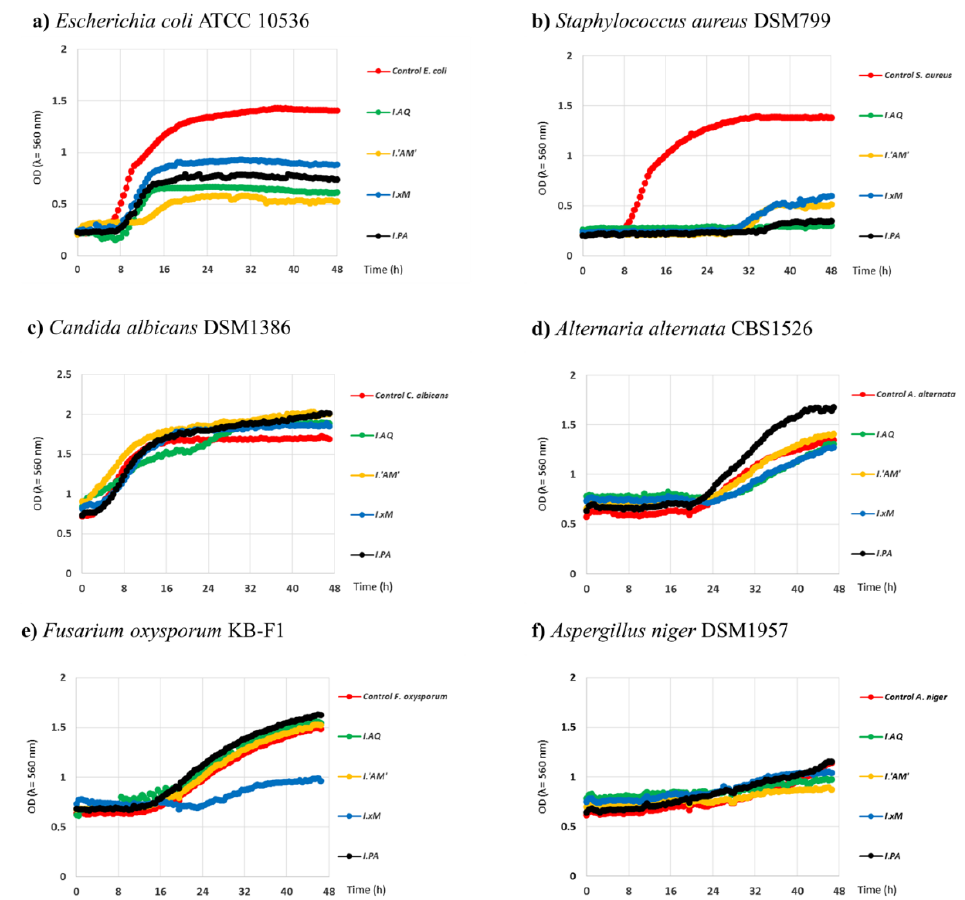
Figure 1. Growth curves of selected strains of bacteria and fungi under the influence of water extracts from Ilex spp in time 48 hours. Legend: I.PA — I. paraguariensis ; I.AQ — I. aquifolium ; I.’AM’ — I. aquifolium ‘Argentea Marginata’; I.×M — I. × meserveae ‘Blue Angel’. See more details in Supplementary materials (Figure S2).